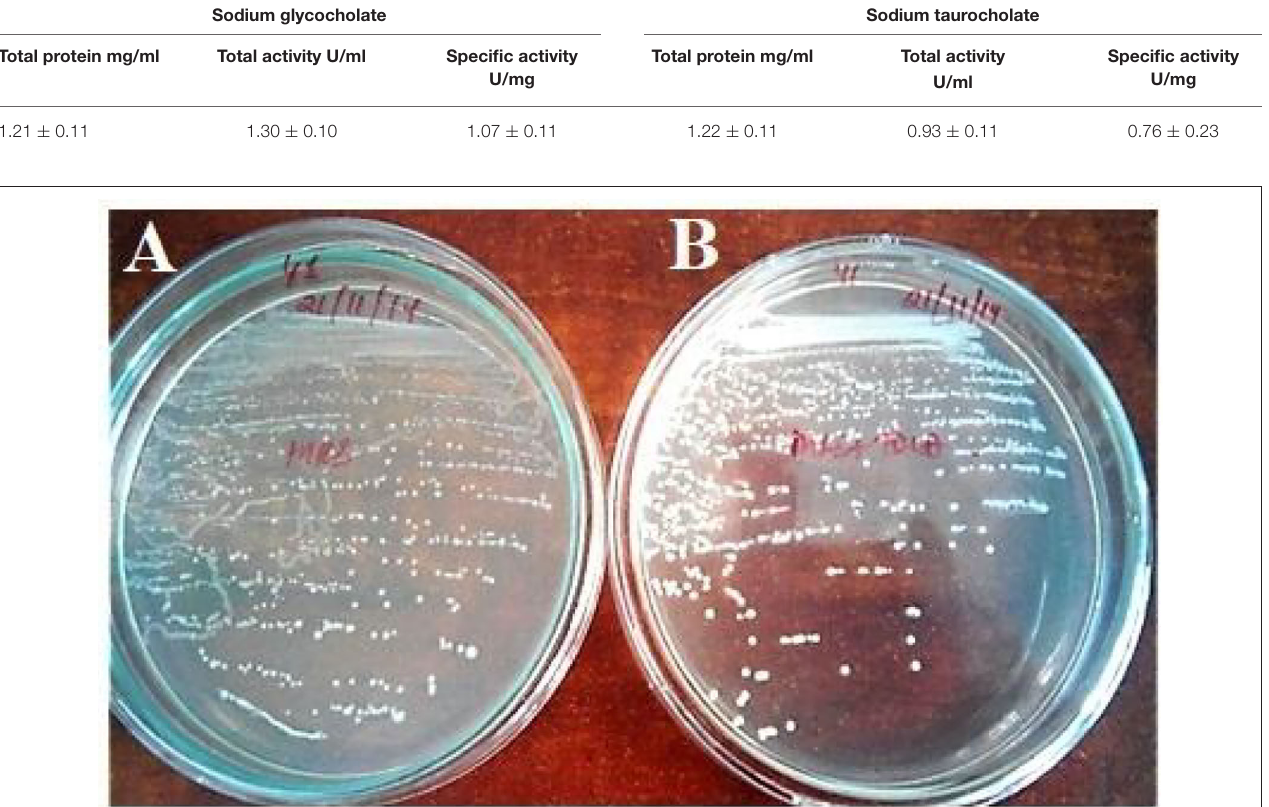
FIGURE 1 | Bile salt hydrolase activity of Enterococcus lactis YY1, (A) On MRS plate and (B) MRS plate supplemented with TDCA.